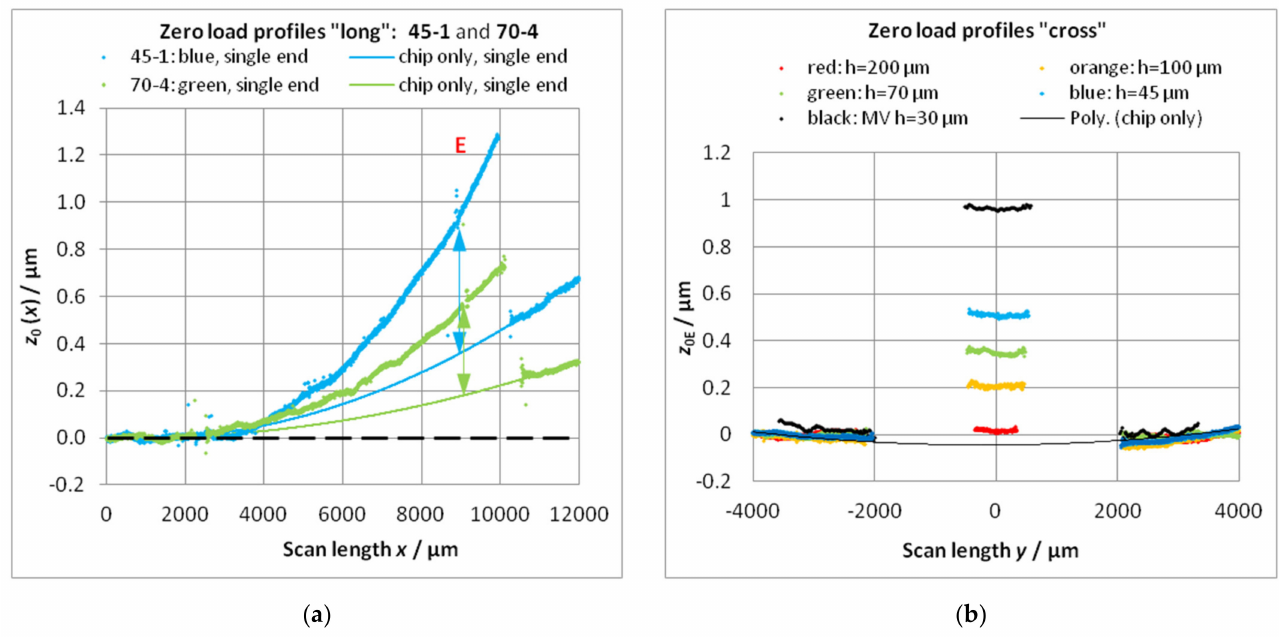
Figure 6. ( a ) The zero-load bending z 0 in the middle of the cantilevers in the direction “long” of the chips 45-1 and 70-4 after single-end leveling. With increasing thickness, the zero-load bending decreases (measured with the autofocus sensor). ( b ) Examples of the zero-load bending z 0 E in the middle of the scans in the direction “cross” (after dual end leveling), depending on the cantilever thickness. With increasing thickness, the zero-load bending decreases (black: measured with the Fizeau interferometer; others: measured with the autofocus sensor). z 0 E —values from the profile “cross” correspond with the arrows in ( a ). In addition, in the cross-direction, the chips can have a little bow (only the largest bow is implemented in ( b